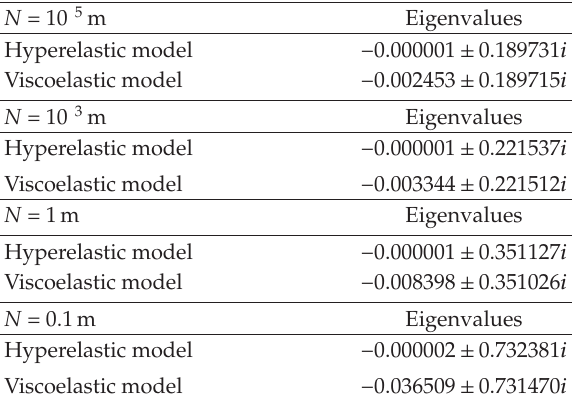
Table 1: Eigenvalues for models with varying N